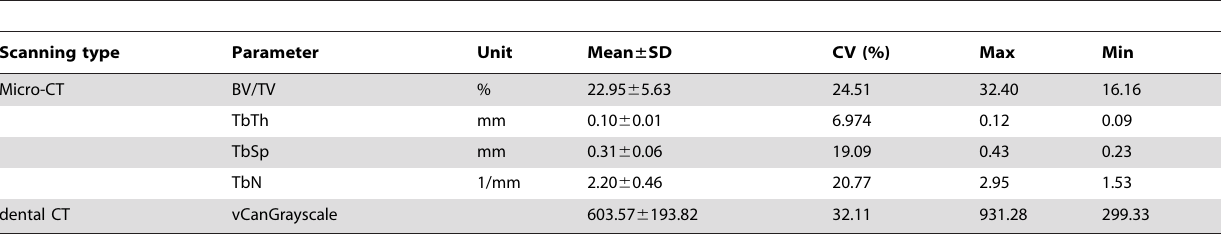
Table 2. Trabecular bone parameters of the 5 th vertebral body: the four trabecular bone microarchitecture parameter (BV/TV, TbN, TbTh, TbSp) measured by micro-CT and the grayscale measured by dental CT.